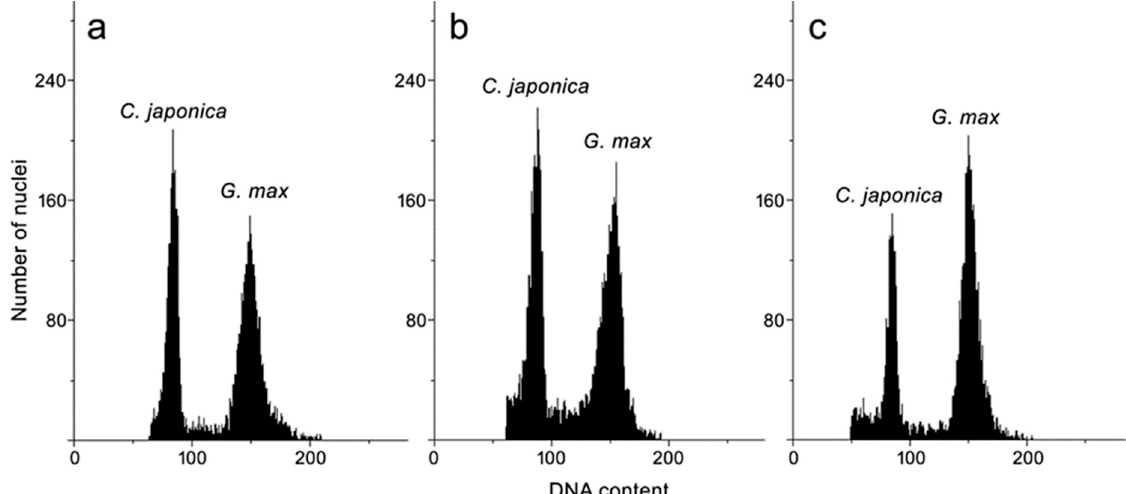
Figure 2. Selected histograms of nuclear DNA content obtained after flow cytometric analysis of the PI-stained nuclei isolated simultaneously from the leaves of Glycine max (internal standard) and Chaenomeles japonica : ( a ) leaves of field-grown plant; ( b ) leaves of aseptic seedlings; and, ( c ) leaves from in vitro-propagated plantlets (shoot culture).